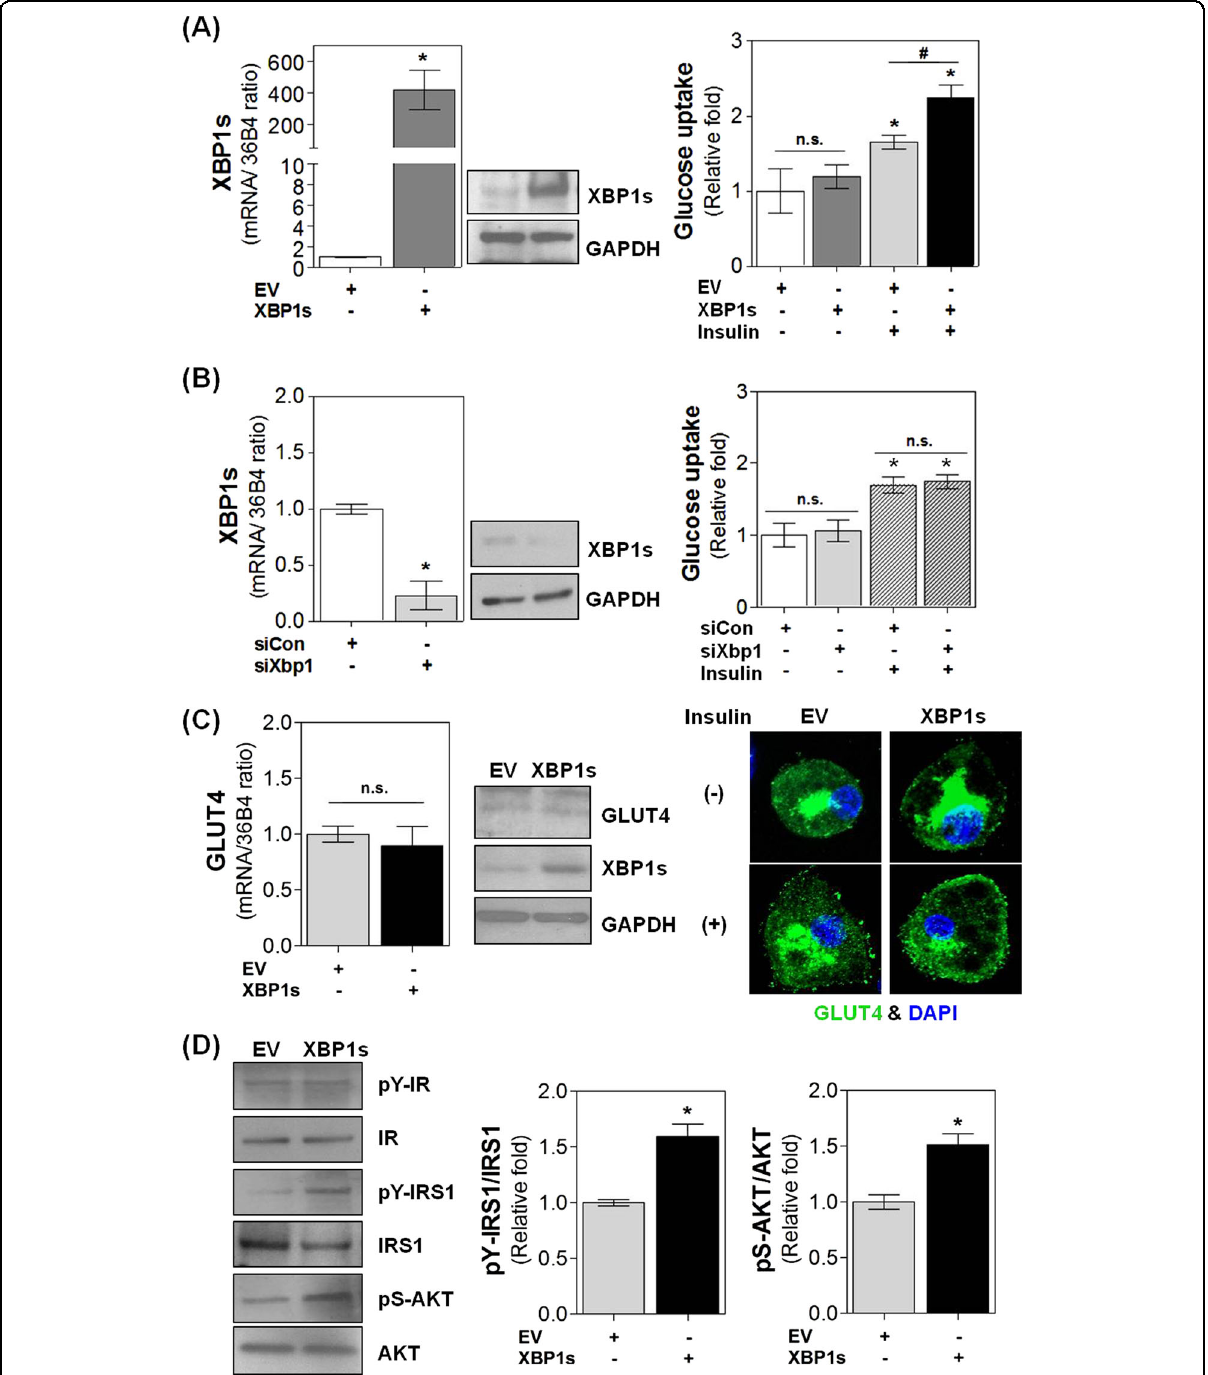
Fig. 1 Effect of XBP1s on insulin-stimulated glucose uptake in 3T3-L1 adipocytes. 3T3-L1 adipocytes were transfected with pcDNA3.1-mXBP1s (XBP1s) or an siRNA against XBP1 (siXBP1), and treated with insulin (1 μ g ml − 1 ) for 30 min as indicated. a , b Intracellular XBP1s mRNA and protein levels and glucose uptake rates were determined. c The expression (left) and translocation (right, green) of GLUT4 were analyzed using real-time PCR/ immunoblot analyses and immuno fl uorescence, respectively. DAPI was used to stain nuclei (right, blue). d The total and phosphorylated expression levels of insulin receptor (IR), insulin receptor substrate 1 (IRS1), and AKT were examined by immunoblot analysis (left) and quanti fi ed with densitometry (right). Values are presented as the means ± SEM of three independent experiments. * P < 0.05 compared to empty vector (EV) or control siRNA (siCon); # P < 0.05 compared to insulin-treated EV. n.s. not signi fi